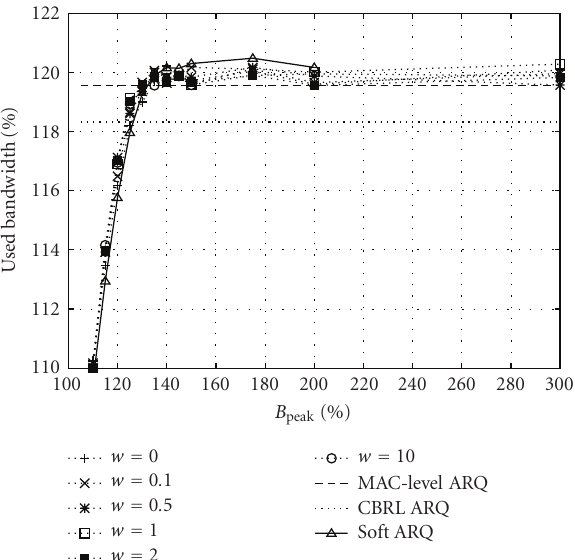
Figure 8: Used bandwidth as a function of the peak bandwidth for the proposed ARQ scheme, compared to the Soft ARQ technique and to the value corresponding to the best PSNR performance of the MAC-level and CBRL ARQ schemes ( paris